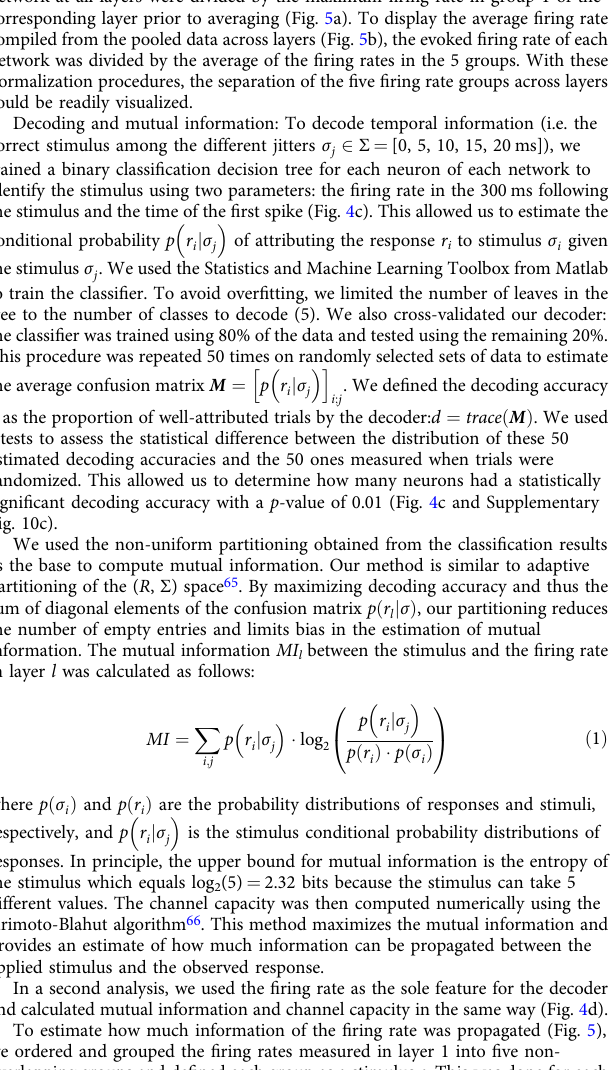
ffiffiffiffiffiffiffiffiffiffiffiffiffi p 37 . N = 320